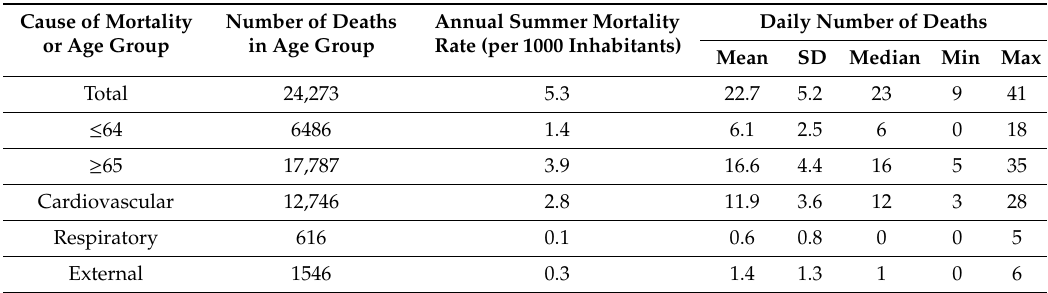
Table 3. Average mortality data for the summer months for the period 2009–2015 in Riga. Cause of Mortality Number of Deaths Annual Summer Mortality or Age Group in Age Group Rate (per 1000